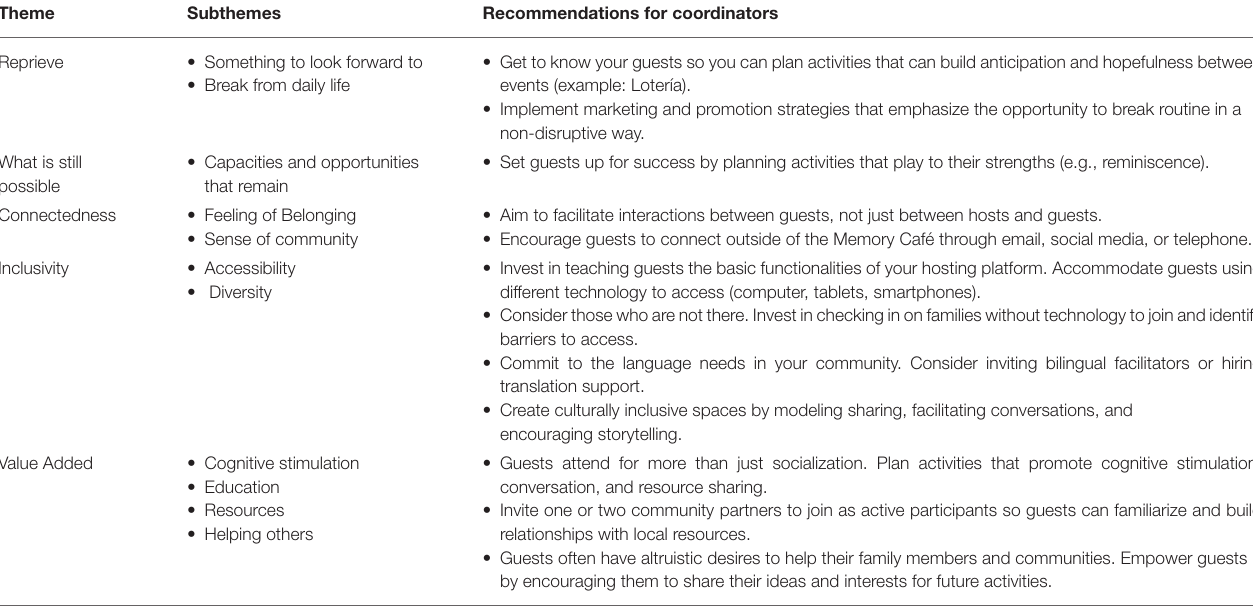
TABLE 3 | Recommendations for coordinators by